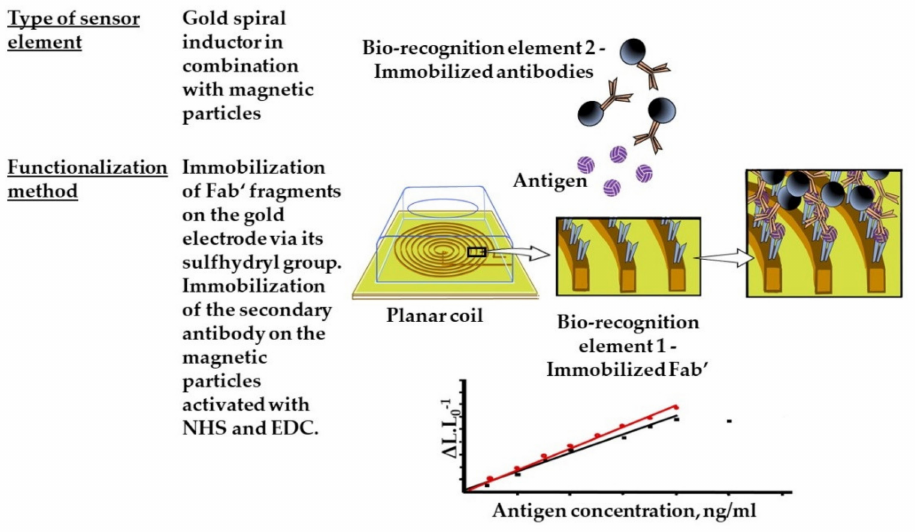
Figure 7. Magnetic inductive micro-electrode for virus